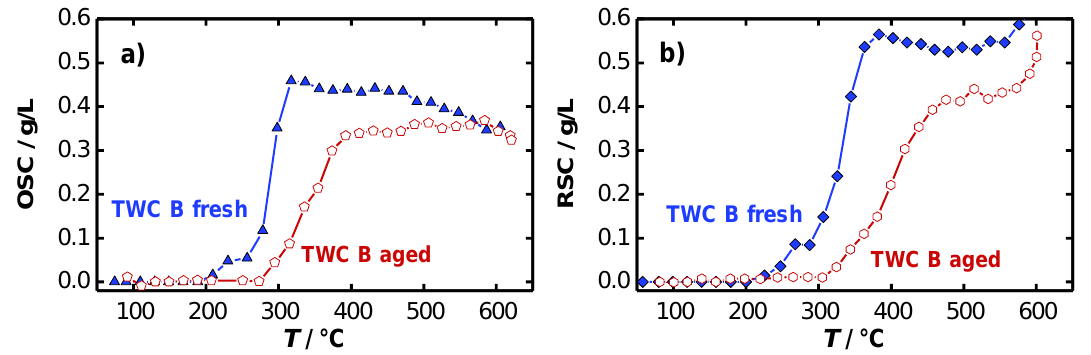
Figure 6. Temperature-dependent ( a ) OSC and ( b ) RSC of the fresh and aged TWC B.